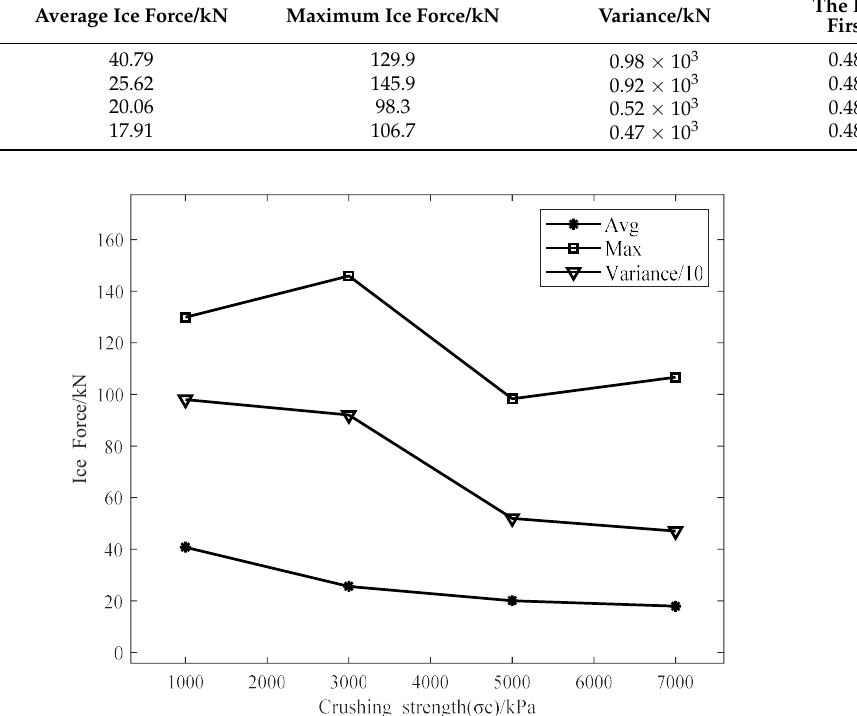
Figure 24. Change trend of variance and ice force with crushing strength ( σ c ).